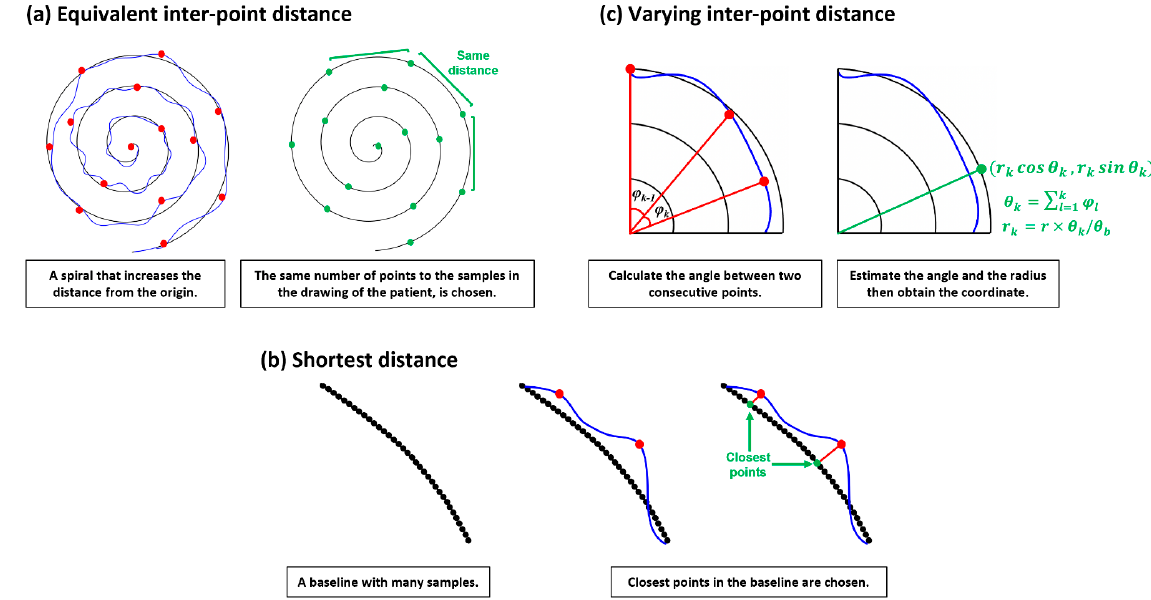
Figure 1. Three approaches for error distance calculation: ( a ) Equivalent inter-point distance. ( b ) Shortest distance. ( c ) Varying inter-point distance.